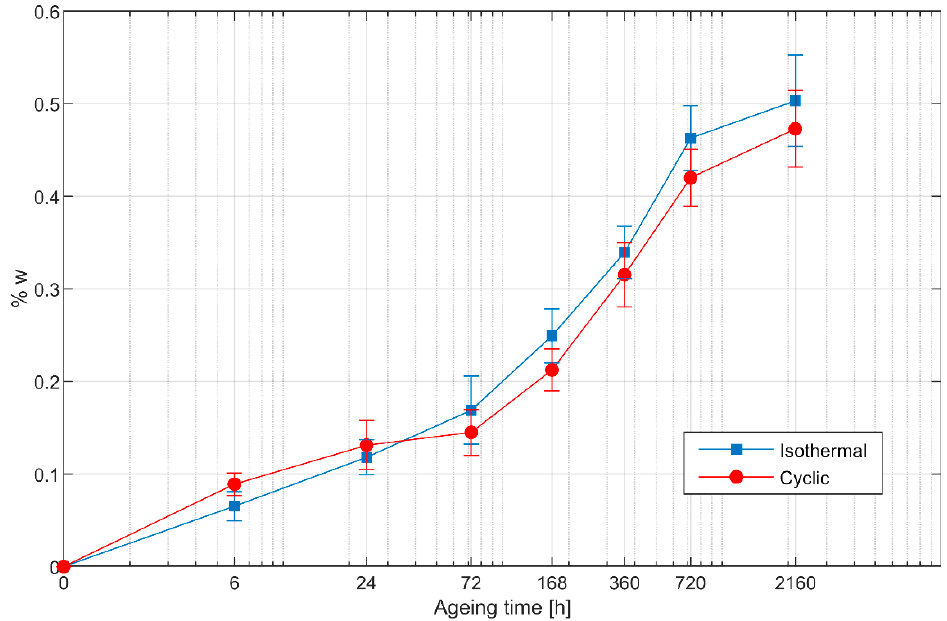
Figure 4. Weight loss for cyclically and isothermally aged specimens. The logarithmic scale on the horizontal axis has been adjusted so that the leftmost point represents the specimens in the unaged condition.